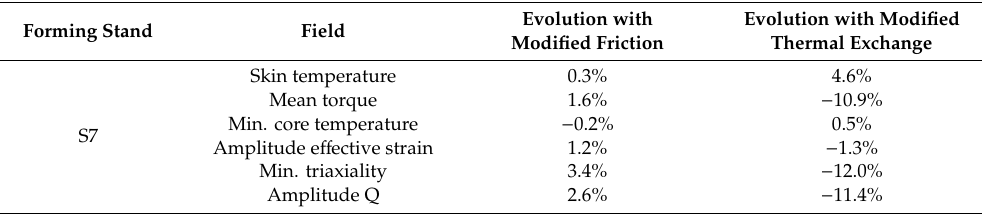
Table 5. Parametric study results: Field variation observed with modified friction and modified thermal exchange.